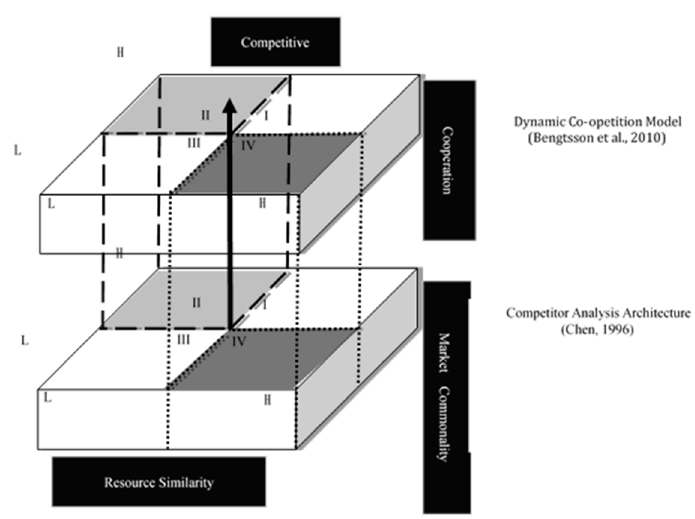
Figure 2. The competitor architecture corresponds with the dynamic coopetition model.